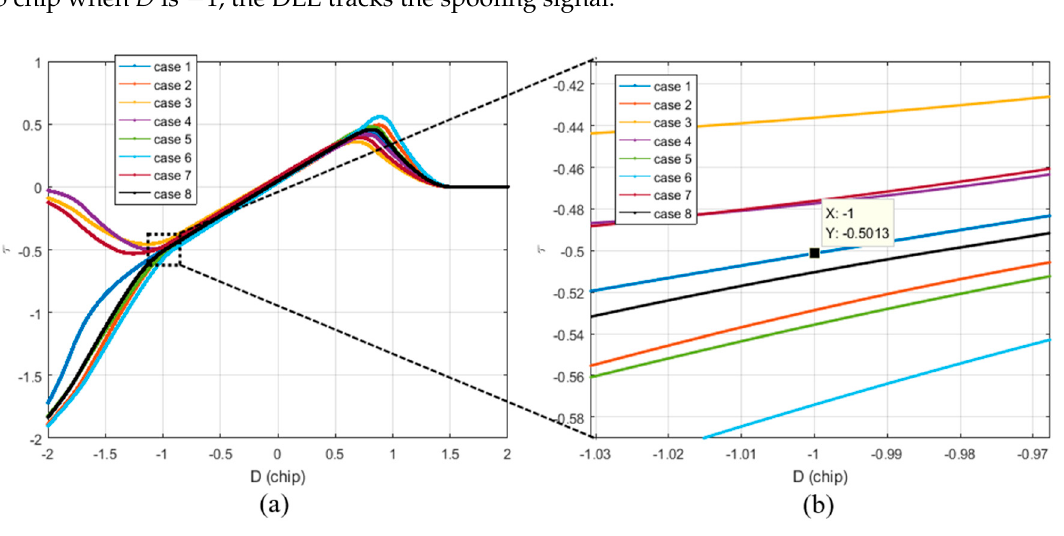
τ Figure 6. Different values at D is -1 according to the spoofing attack success or failure. (a) Overall τ values at D is -1. histories; (b)